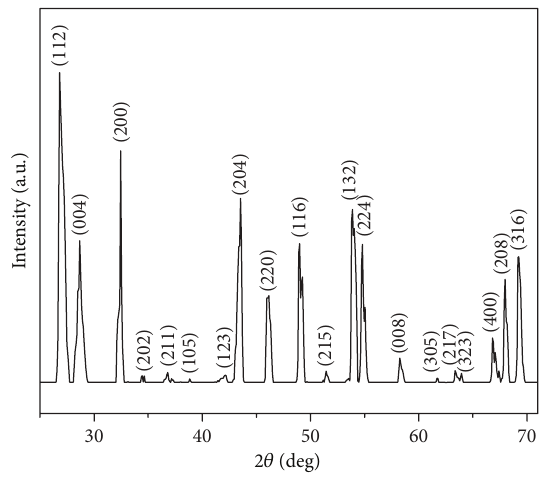
Figure 1: XRD pattern of as-prepared BaWO 4 nanopowder. The electrons reflected and diffracted from the different crystallographic planes of the unit cells of BaWO 4 produce these bright spots. These well distinguished rings are a clear evidence of the high crystalline nature of the